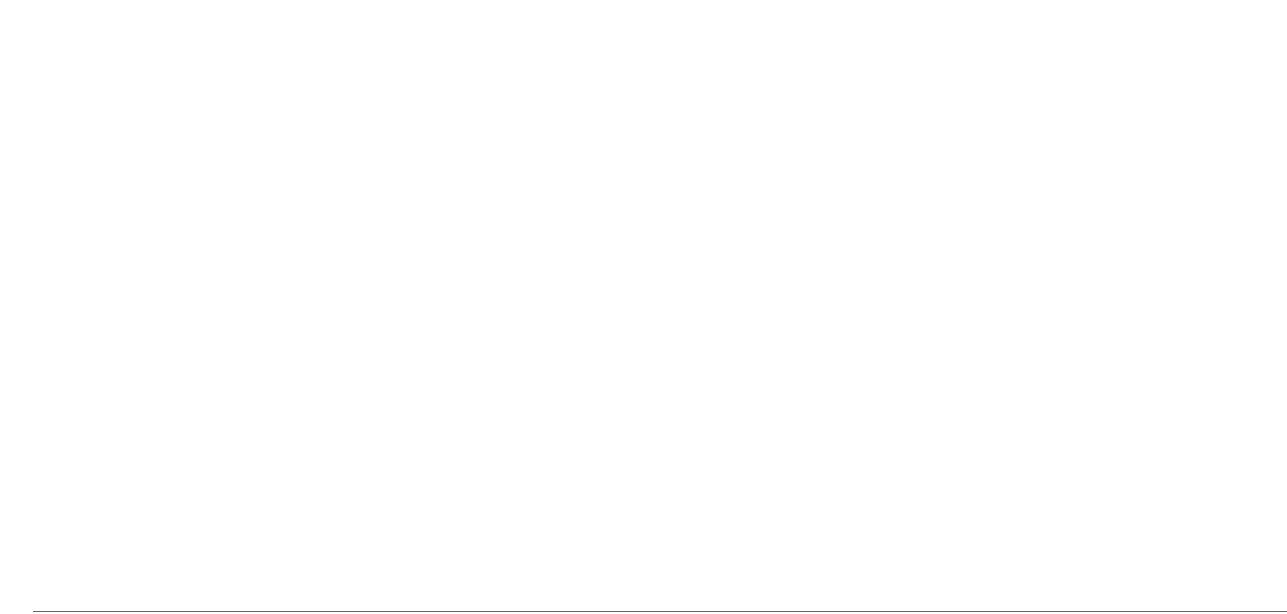
Frontiers in Bioengineering and Biotechnology | www.frontiersin.org